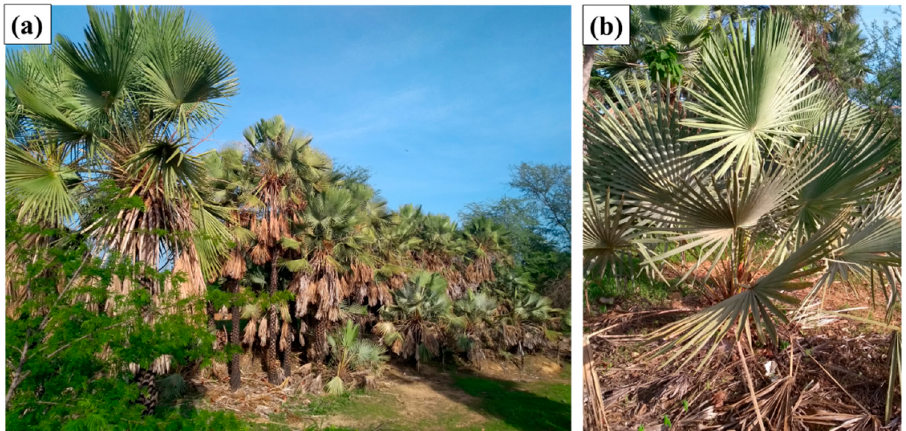
Figure 1. Plantation of carnaubeiras ( a ) and typical leaf-stalks of carnauba tree ( b ).